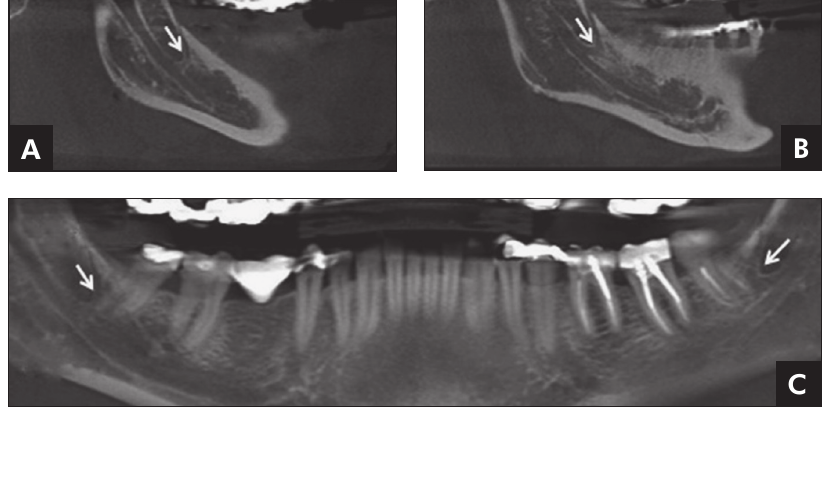
Figure 3 - Unilateral bifurcation (left side) extending along the main canal and united again in the mandibular body (Type 2UC). Left axial cut ( A ), lateral ( B ) and panoramic ( C ) views. The white arrows indicate the bifurcation and the black arrow indicates the mandibular canal.